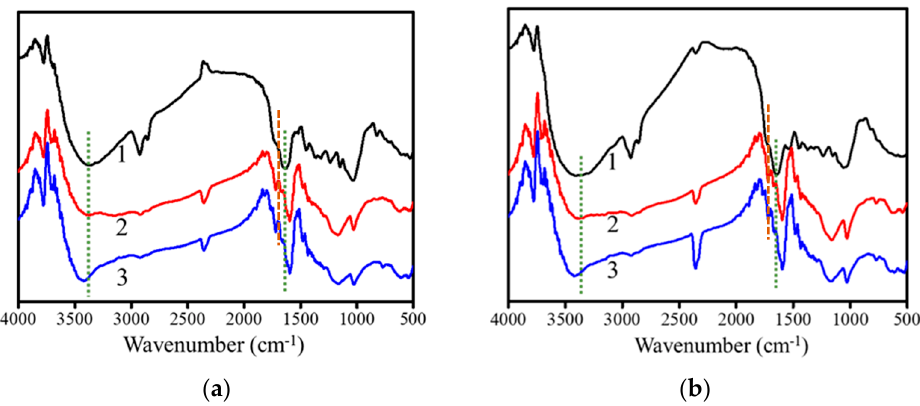
Figure 10. FT-IR spectra of adsorbents, ( a ) 1 FT, 2 CFT, 3 CFT- adsorbed Cs + and ( b ) 1 UT, 2 CUT,